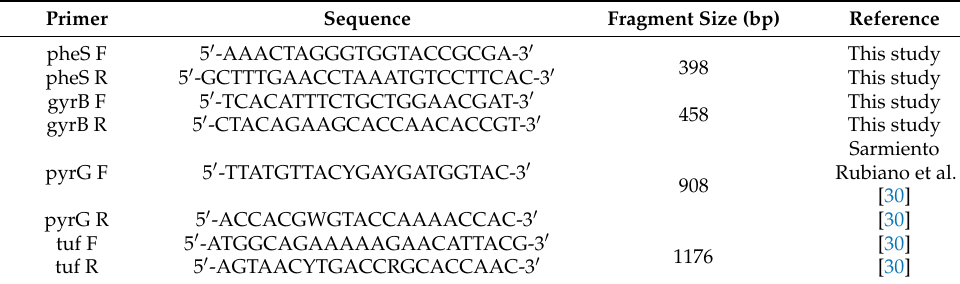
Table 1. Primers used in phylogenetic analysis of isolated